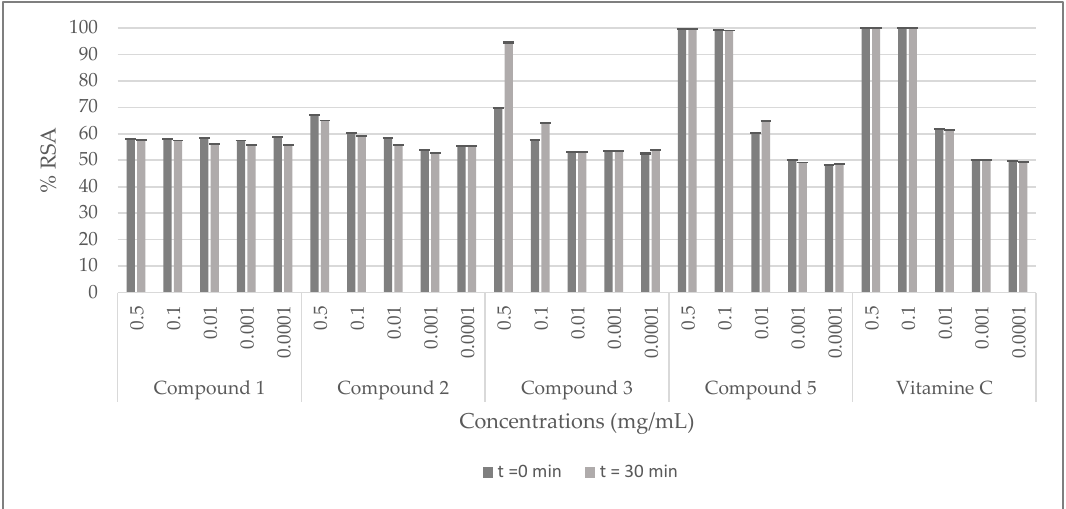
Figure 2. DPPH radical scavenging effects of C. villosa stems extracts. All values are expressed as mean of triplicate ± SD.